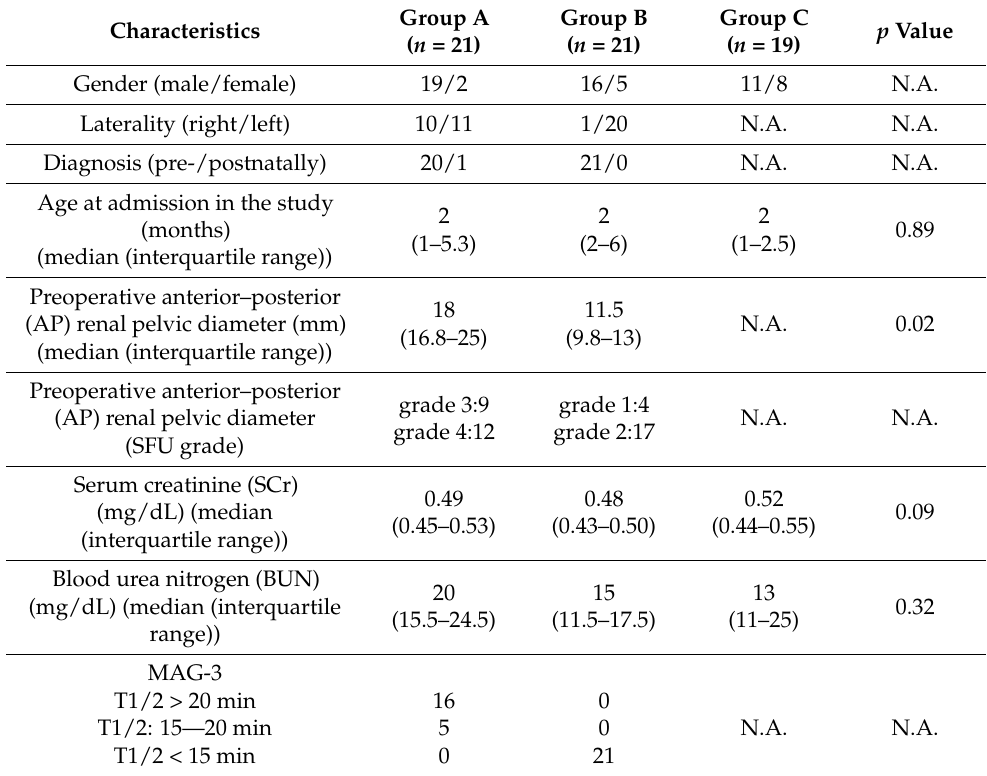
Table 1. Demographic and clinical characteristics of the UPJO patients and controls of the present